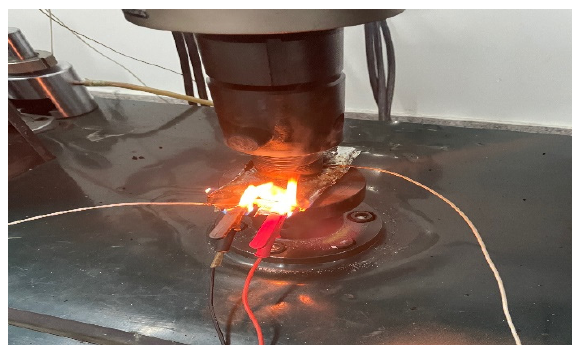
Figure 20. Battery fire during crash test.